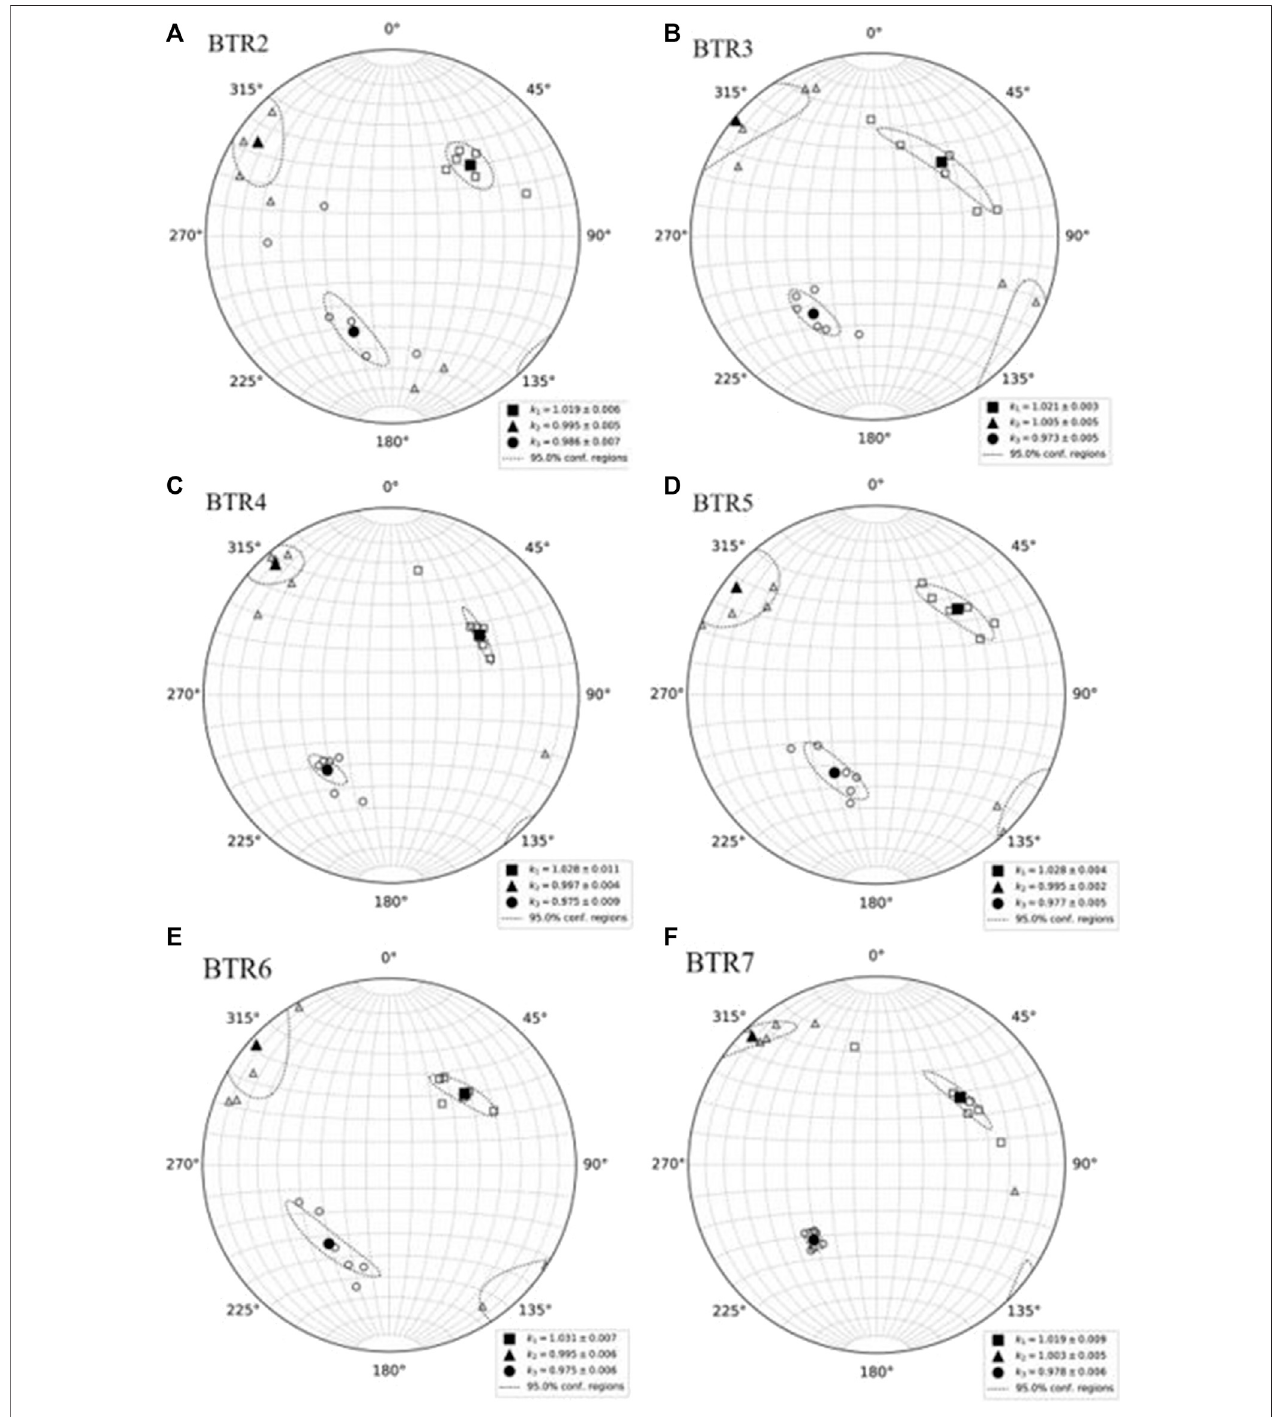
FIGURE 4 | The declination and inclinations of each susceptibility axes for all specimens are projected onto the lower hemisphere of equal area stereoplots of (A) BTR2; (B) BTR3; (C) BTR4; (D) BTR5 and (E) BTR6; and (F) BTR7. Large fi lled symbols represent the mean vector of each corresponding axis. Circles show the 95% area of con fi dence. K 1 (cid:1) maximum susceptibility, K 2 (cid:1) intermediate susceptibility, and K 3 (cid:1) minimum susceptibility.